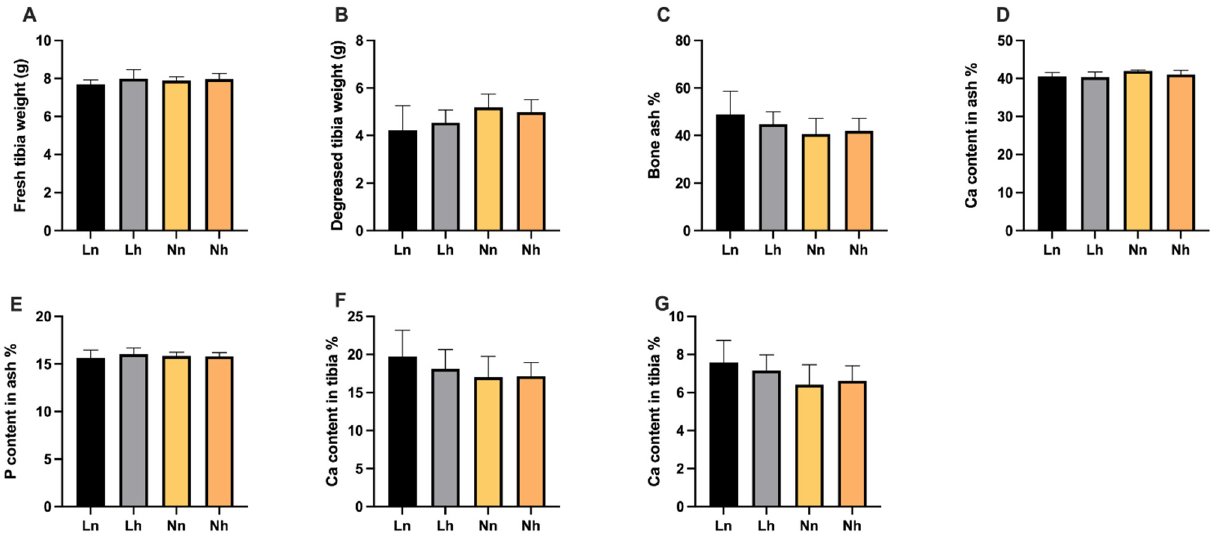
Figure 5. Effects of phosphorus restriction in brooding stage and subsequent recovery on tibia characters of layers at 20 weeks of age. ( A ) Fresh tibia weight ( B ) Decreased tibia weight ( C ) Bone ash ( D ) P content in ash ( E ) Ca content in ash ( F ) Ca content in tibia ( G ) P content in tibia. Data are shown as mean ± SEM. Ln = group fed 0.13% nPP at 1–8 weeks and fed 0.39% nPP at 9–20 weeks; Lh = group fed 0.13% nPP at 1–8 weeks and fed 0.45% nPP at 9–20 weeks; Nn = group fed 0.45% nPP at 1–8 weeks and fed 0.39% nPP at 9–20 weeks; Nh = group fed 0.45% nPP at 1–8 weeks and fed 0.45% nPP at 9–20 weeks. n = 6 per group.